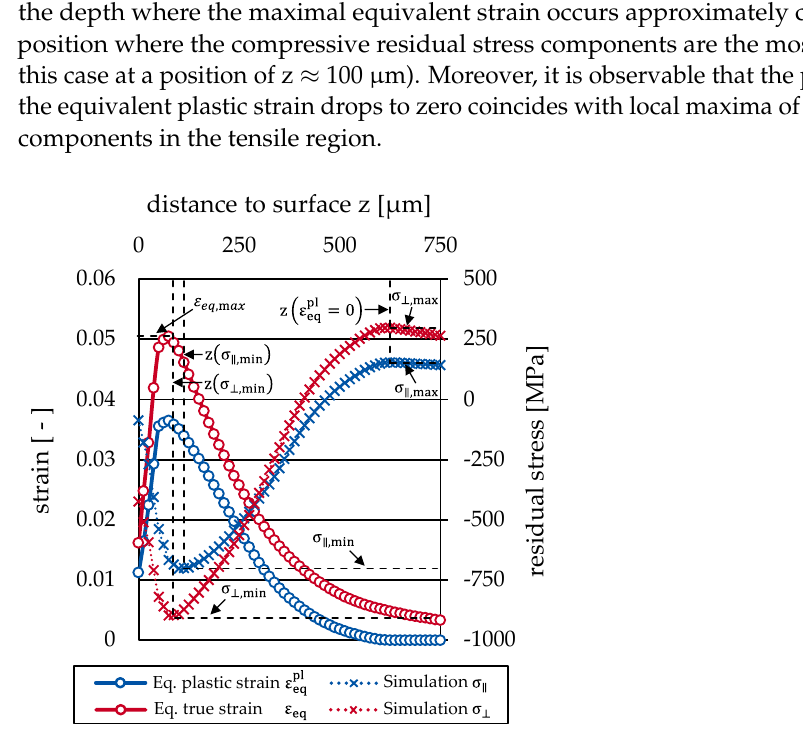
Figure 13. Depth profiles of the equivalent strains during deep rolling and the residual stress components after relaxation for a deep rolling force F r = 497 N at 25 °C. All values derived from simulations.